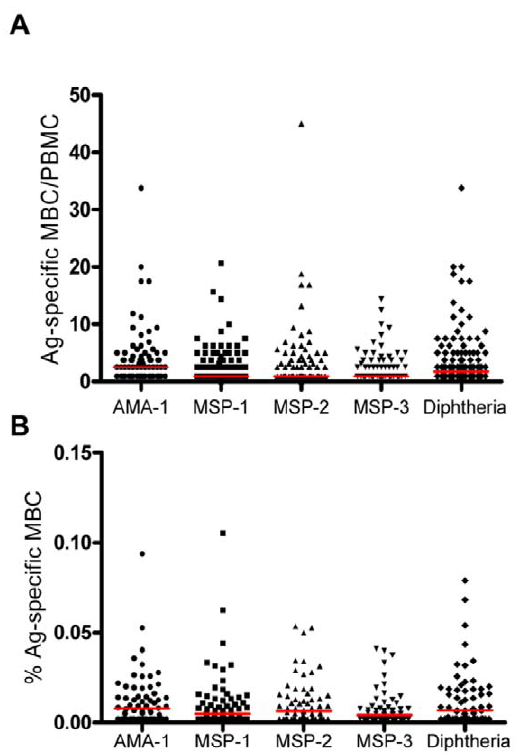
Figure 7. Naturally acquired MBC responses to malaria antigens are similar in magnitude to vaccine-induced MBC responses to DT. Ag-specific ELISpot responses of individuals with immunological evidence of prior malaria exposure are shown and expressed as (A) MBC/PBMC and (B) % MBC, for each Ag. The median for each group is indicated by the horizontal line. The p value (Kruskal Wallis test) for (A)=0.08, and (B)=0.178.